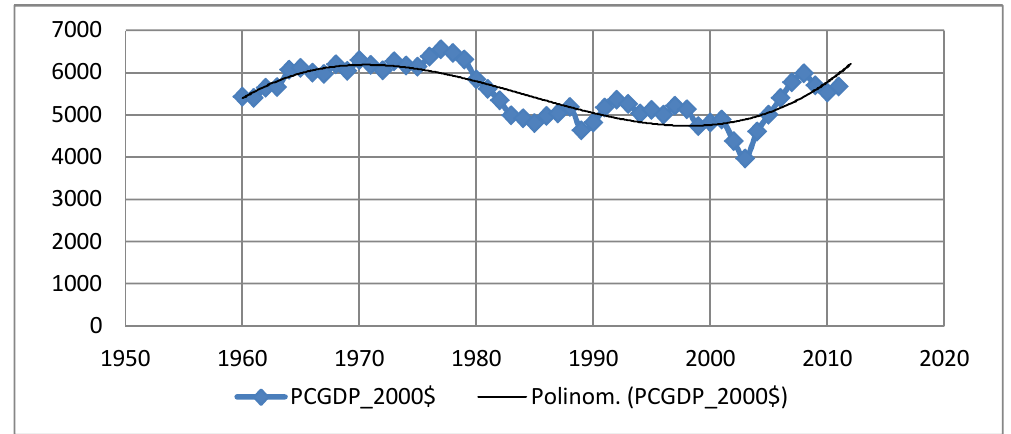
Figure 1: Trends of Venezuela's PCGDP during